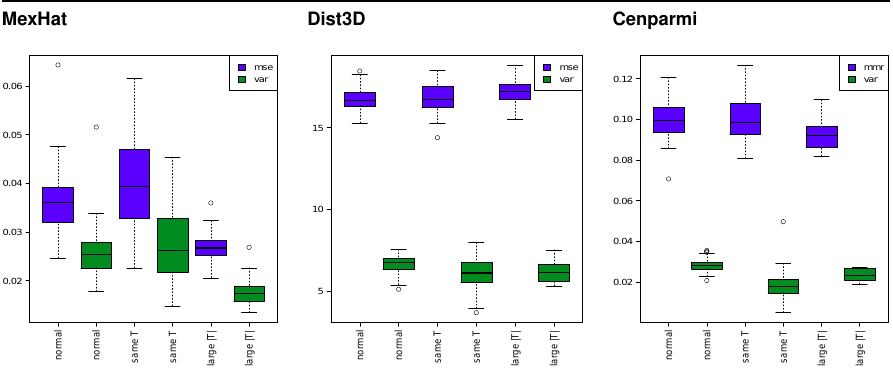
Fig. 5. A comparison of the effect of selection of training set T on c mse or boxplots: dark lines are median values, boxes are based on quintiles, whiskers represent the 95% confidence interval, circles are